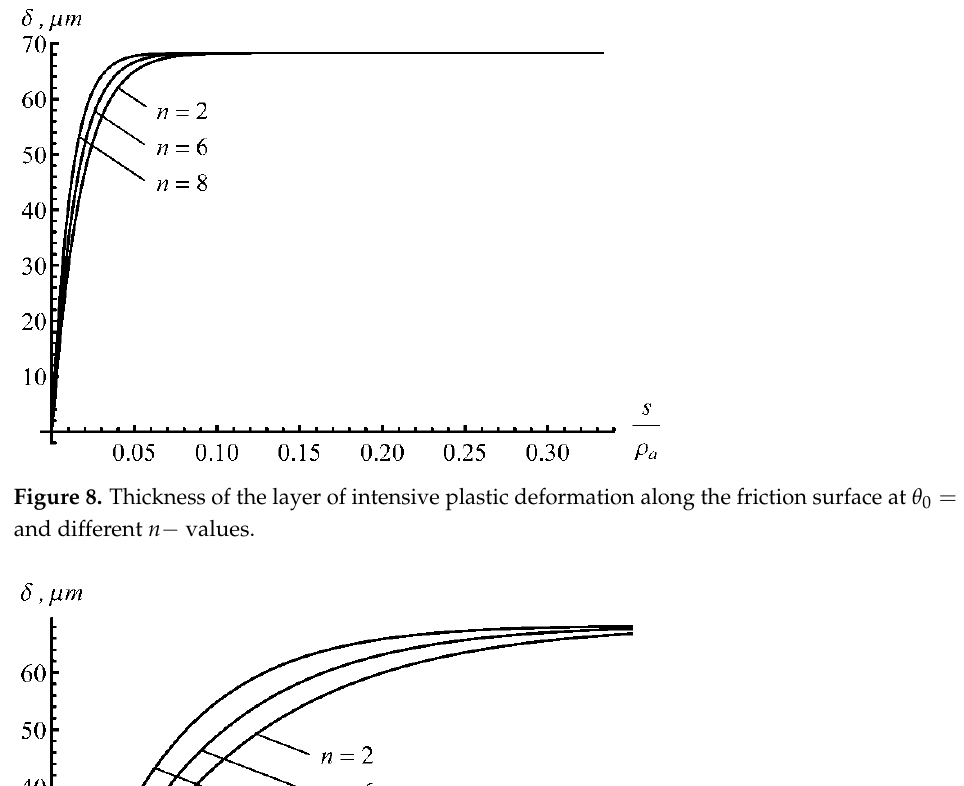
Figure 9. Thickness of the layer of intensive plastic deformation near the entrance to the die and different n values.